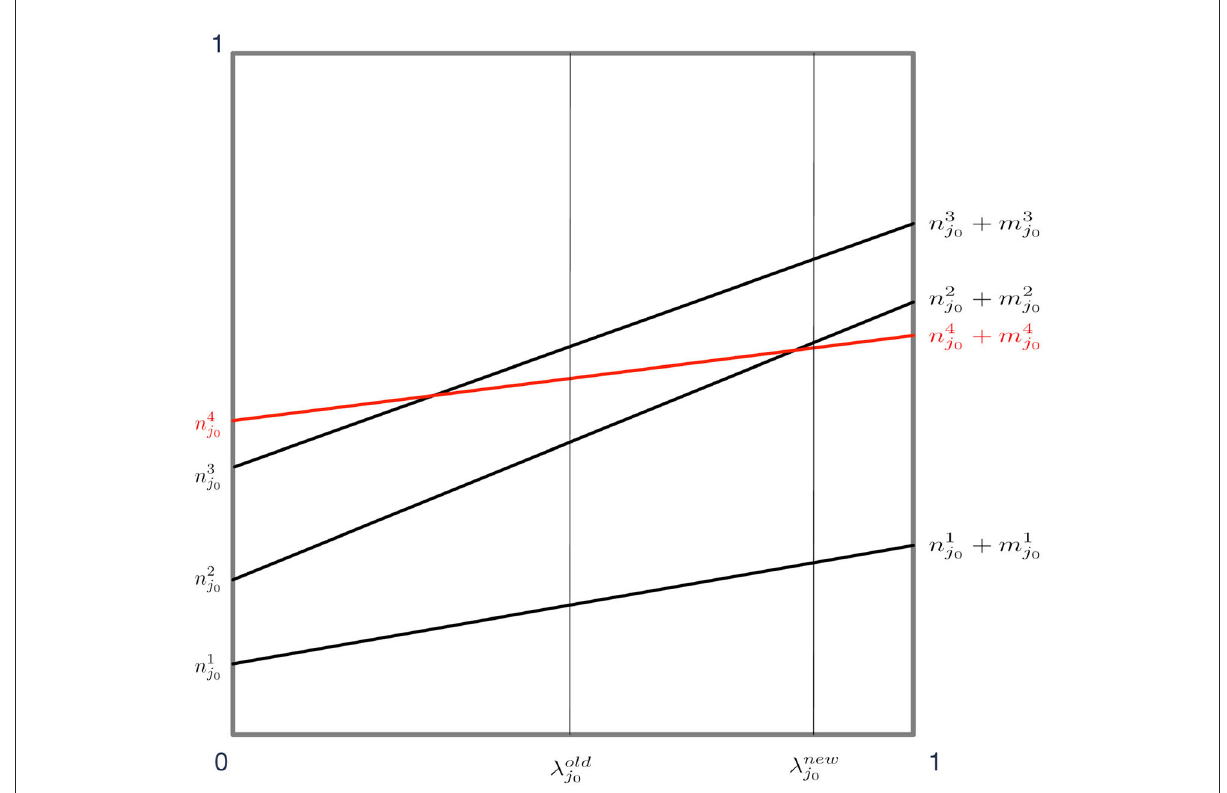
FIGURE6 on separating I 1 -objects (black) from I 0 -objects Impact of λ j 0